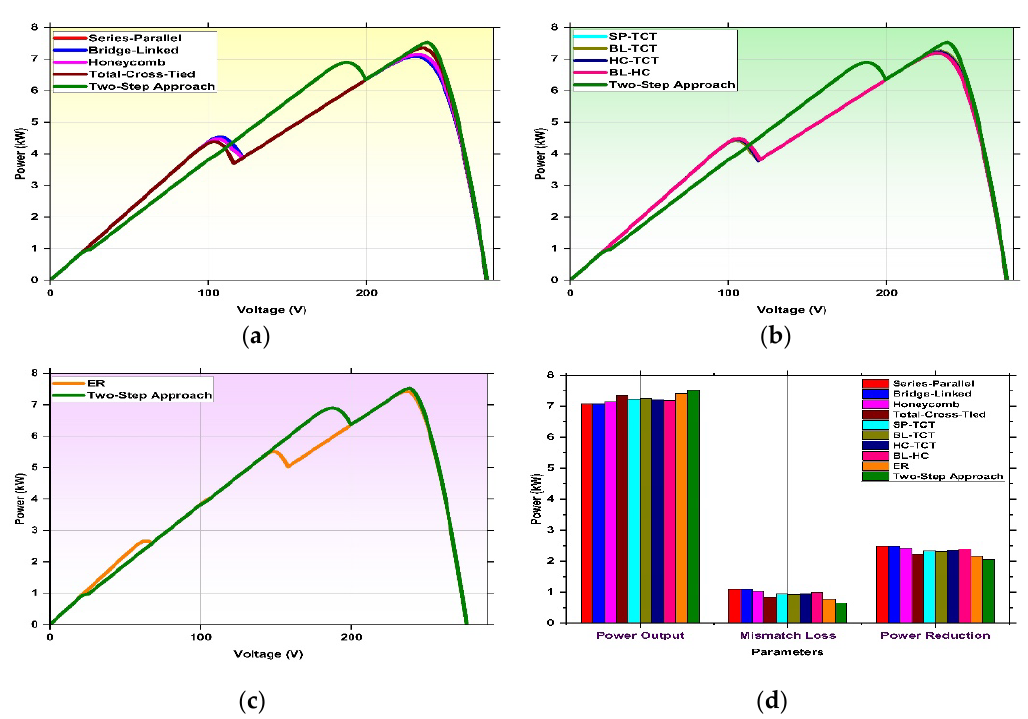
Figure 8. Graphical comparison of two-step approach under partial shading S1. ( a ) P~V curve com- parison with conventional configurations, ( b ) P~V curve comparison with hybrid configurations, ( c ) P~V curve comparison with the static reconfiguration technique, and ( d ) comparison of the param- eters among all configurations.